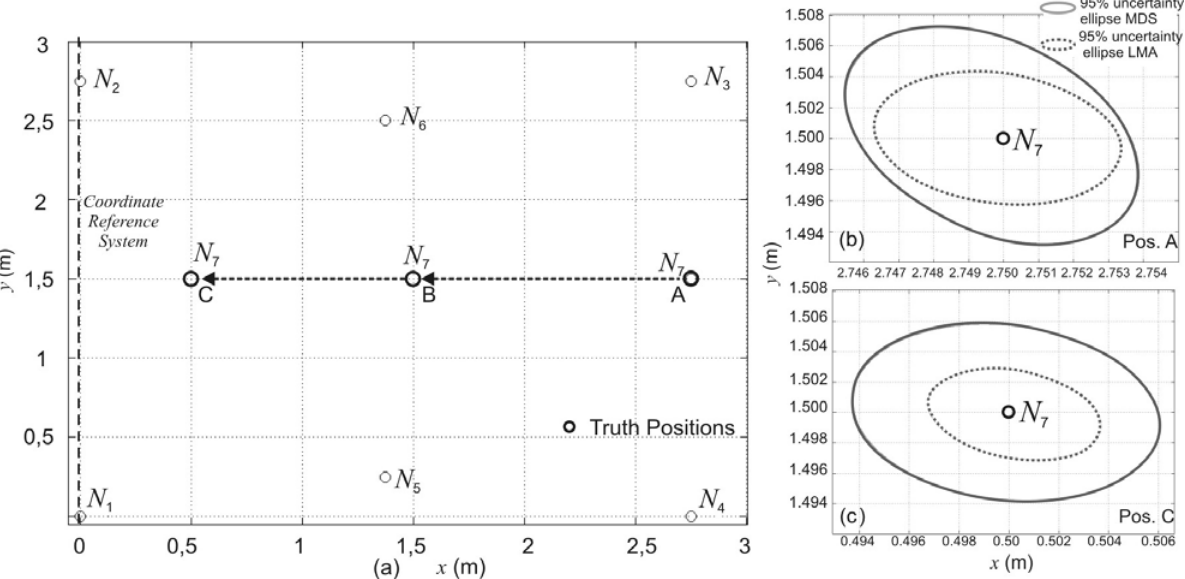
Figure 8. Position estimation when changing the topology of